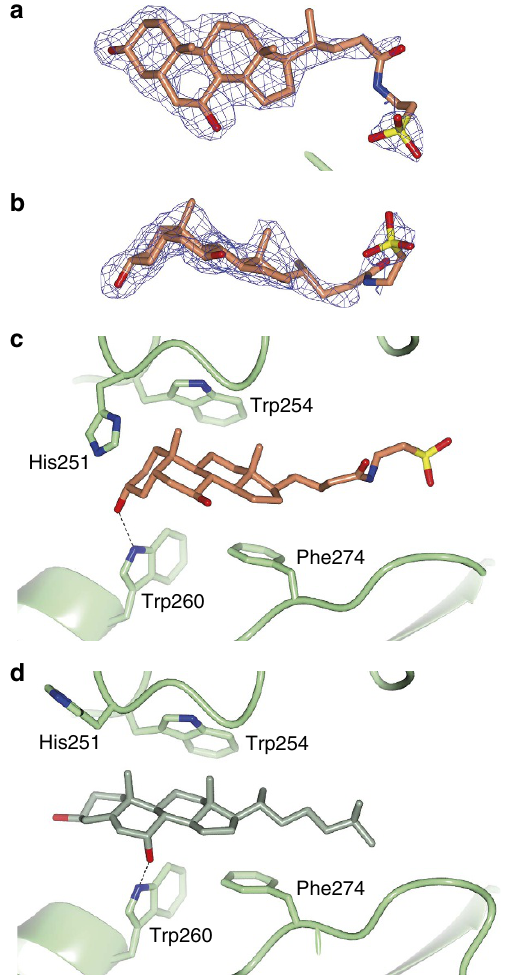
Figure 4 | The bile salt TUDCA binds the tunnel of ATX. ( a , b ) The 2mF o -DF c electron density map before ligand placement is contoured at 1.2 RMS and shown as a blue wireframe model in two views; TUDCA (orange carbons; oxygens in red, sulfur in yellow and nitrogen in blue) is shown as a stick model. ( c , d ) Comparison of the binding of TUDCA and 7 a -hydroxycholesterol; Trp260 forms a hydrogen bond (dotted line) with the 3 a -OH of TUDCA (in orange), whereas it forms a hydrogen bond with 7 a -OH of the hydroxycholesterol (in green). In the TUDCA-bound structure, His251 flips towards the A-ring, whereas in both structures Trp260 and Phe274 pack against the steroid ring